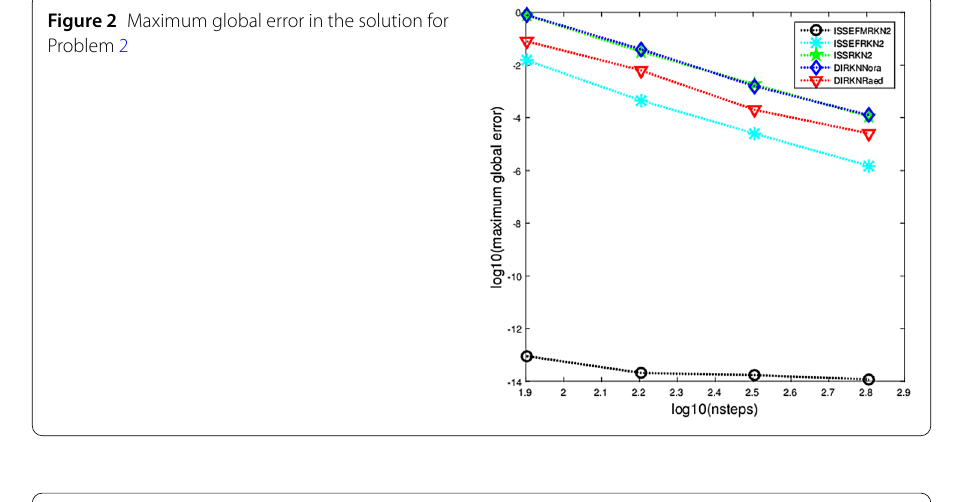
Figure 2 Maximum global error in the solution for Problem 2